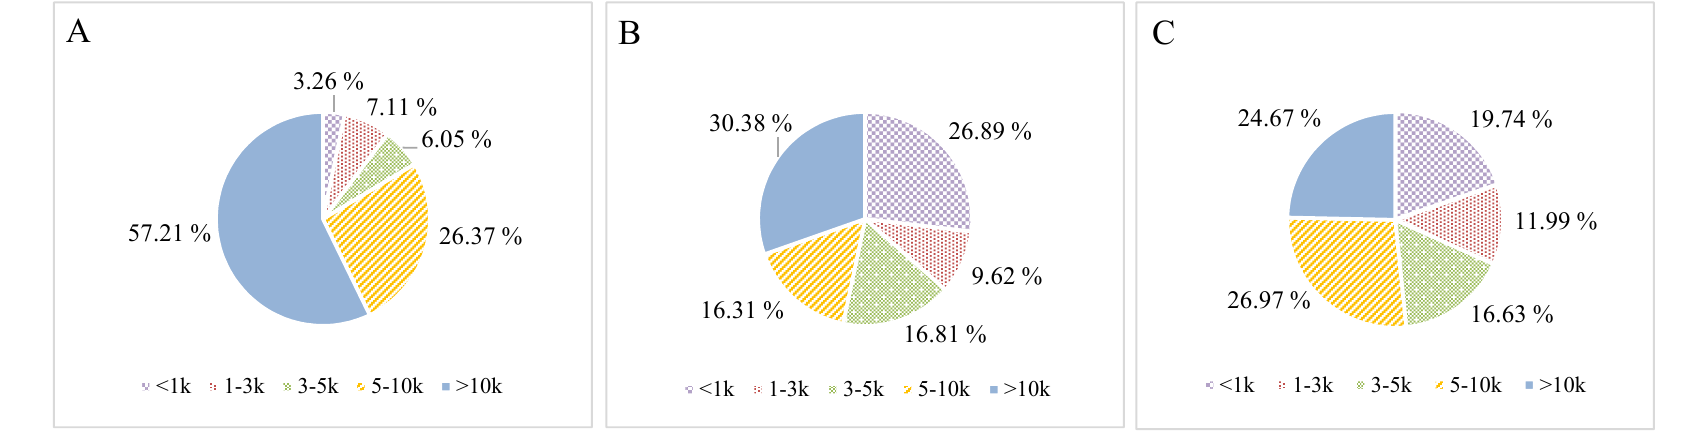
Figure 5. Antioxidant yield of peptide fractions ultrafiltrated from CGM hydrolysates prepared by: ( A ) Papain with 3 h reaction; ( B ) ficin with 4 h reaction; and ( C ) bromelain with 4 h reaction.